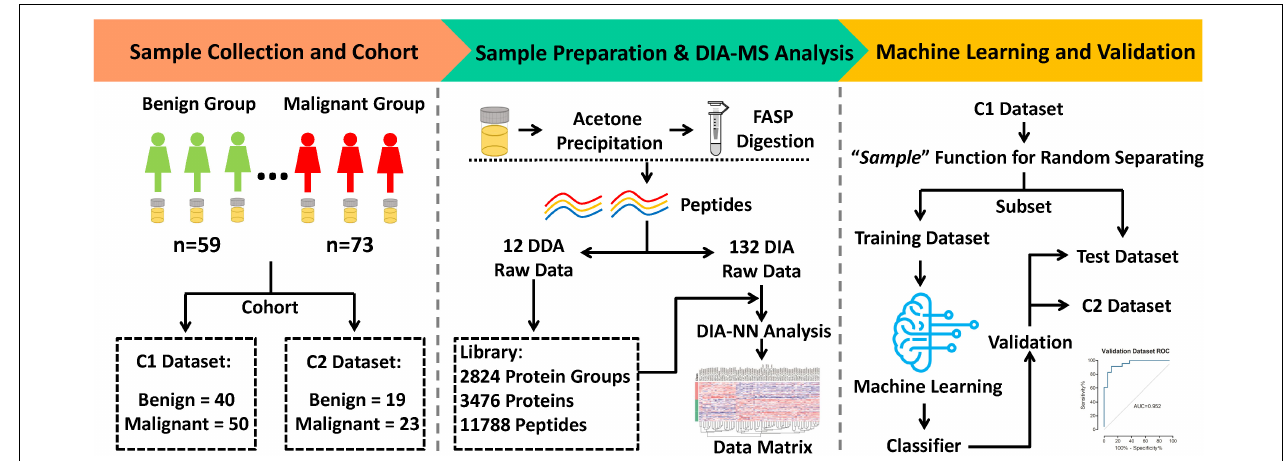
FIGURE 1 | Workflow of MS analysis from urinary proteomics based on machine learning for distinguishing between benign and malignant ovarian tumors.